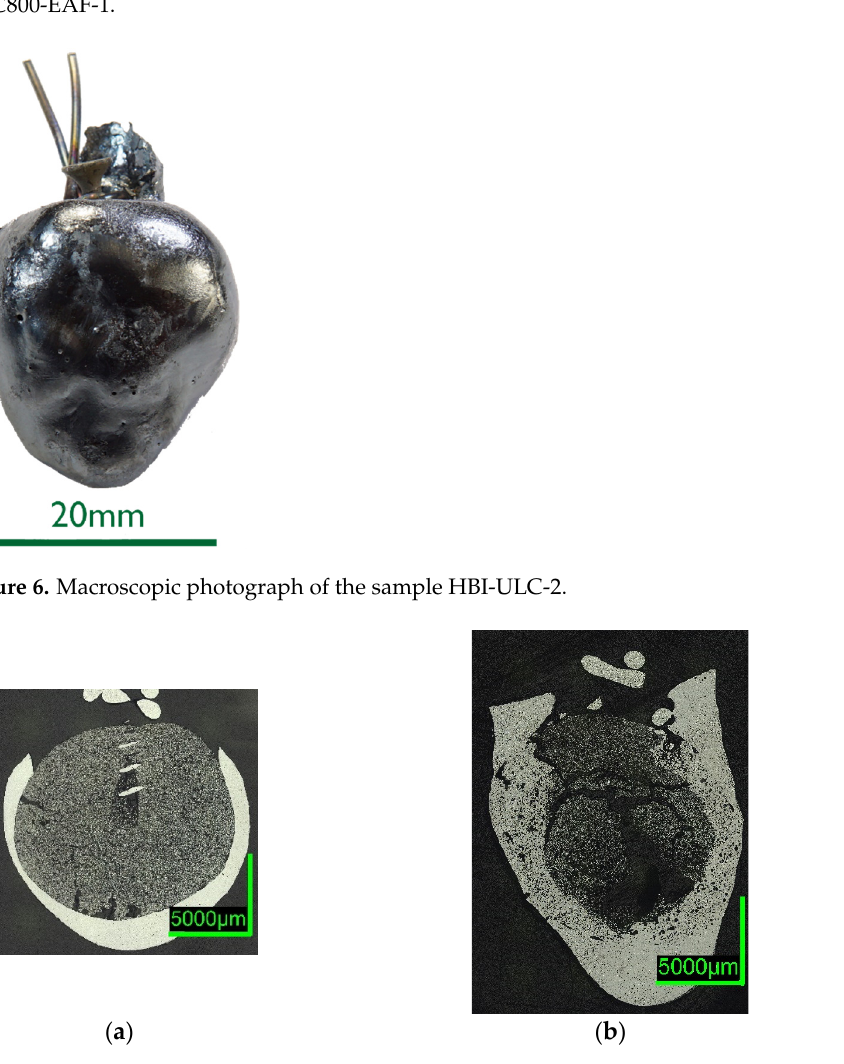
Figure 5. Macroscopic photographs of selected C800 samples: ( a ) C800-ULC-4; ( b ) C800-SAF-1; ( c ) C800-EAF-1.